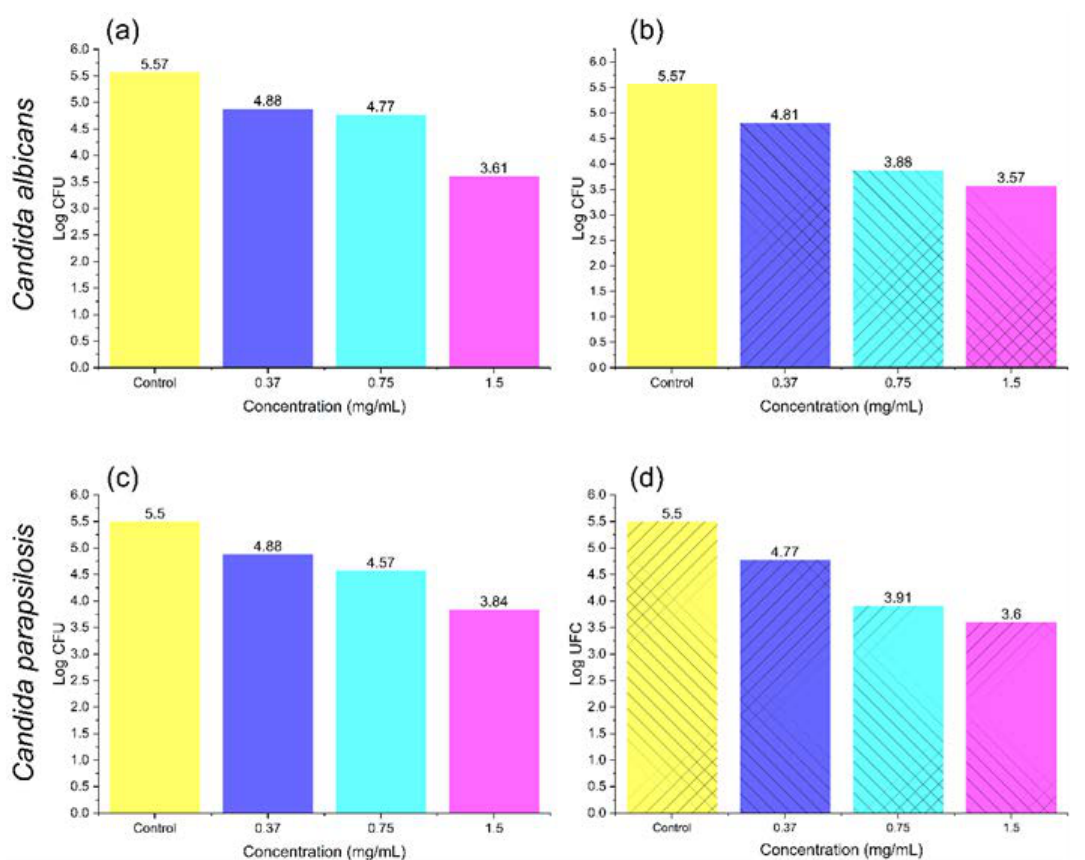
Figure 6. Antifungal activity on Candida albicans and Candida parapsilosis of ( a , c ) coffee husk, ( b , d ) AgNPs–coffee